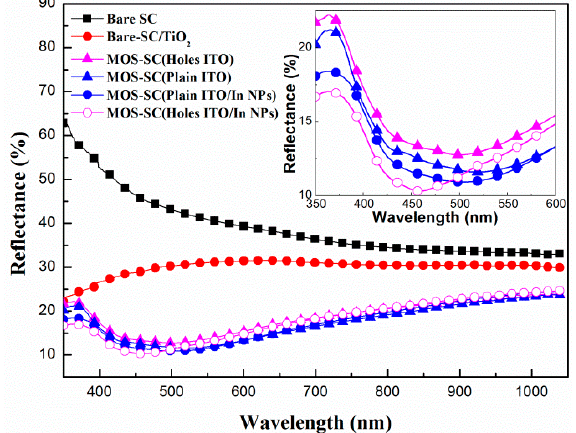
Figure 2. Optical reflectance of bare cell, cell with TiO 2 film, MOS cell with plain ITO electrode, MOS cell with perforated ITO electrode, MOS cell with plain ITO electrode and In-NPs, and MOS cell with perforated ITO electrode and In-NPs.